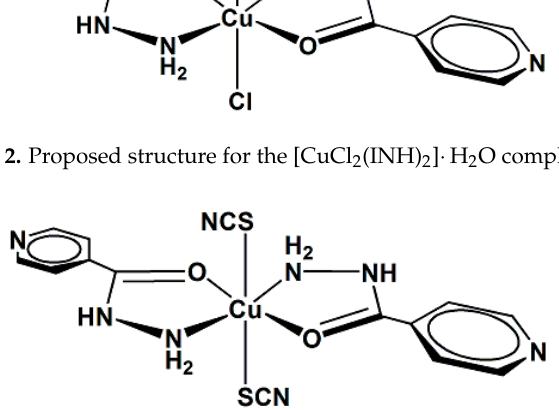
Figure 3. Proposed structure for the [Cu(NCS) 2 (INH) 2 ]·5H 2 O complex ( 2 ).